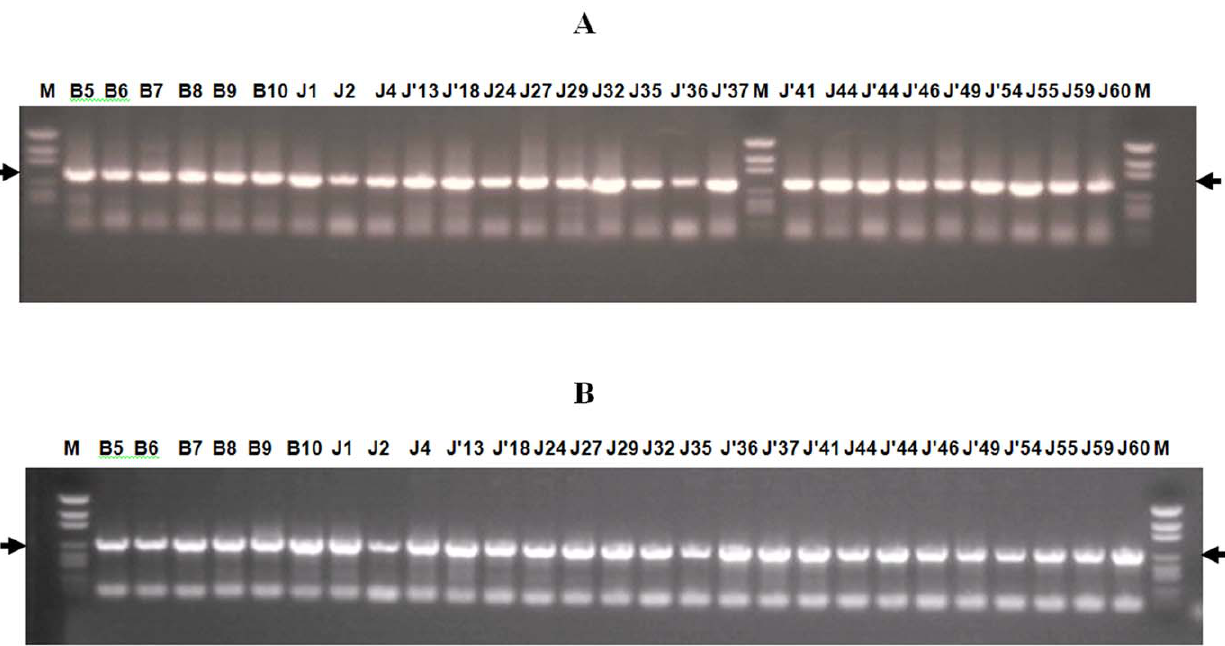
Figure 1. PCR amplicons from segments 10 and 12 of LNV isolates from Xinjiang province. A: amplicon obtained using primers LNV10s/ LNV10r1 (products size 845 bp), B: amplicon obtained using primers LNV12S/LNV10R (products size 675 bp).the PCR products were run on 1% agarose gel in TAE buffer and subsequently stained with ethidium bromide. doi:10.1371/journal.pone.0037732.g001 unique LNV-2 isolate (LNV-NE9731), nt identity levels ranged LNV Seg-10 encodes the cell-attachment protein VP10, which from 87.7% to 87.8%, with 99.8% to 99.9% aa identities in VP12 determines virus serotype [14]. The level of nt identity detected in (again reflecting multiple ‘silent’, third base changes). Seg-10 between the 27 new isolates ranges from 94.3% to 100%, with 99.0% to 100%aa identity in VP10. These levels are